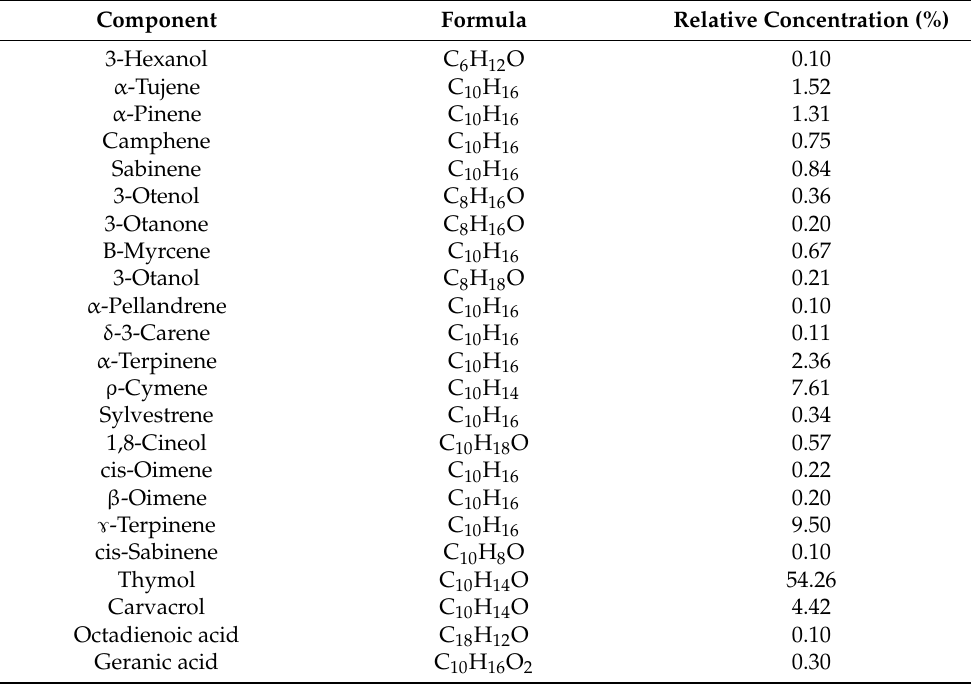
Table 1. Chemical composition of thyme essential oils [16].